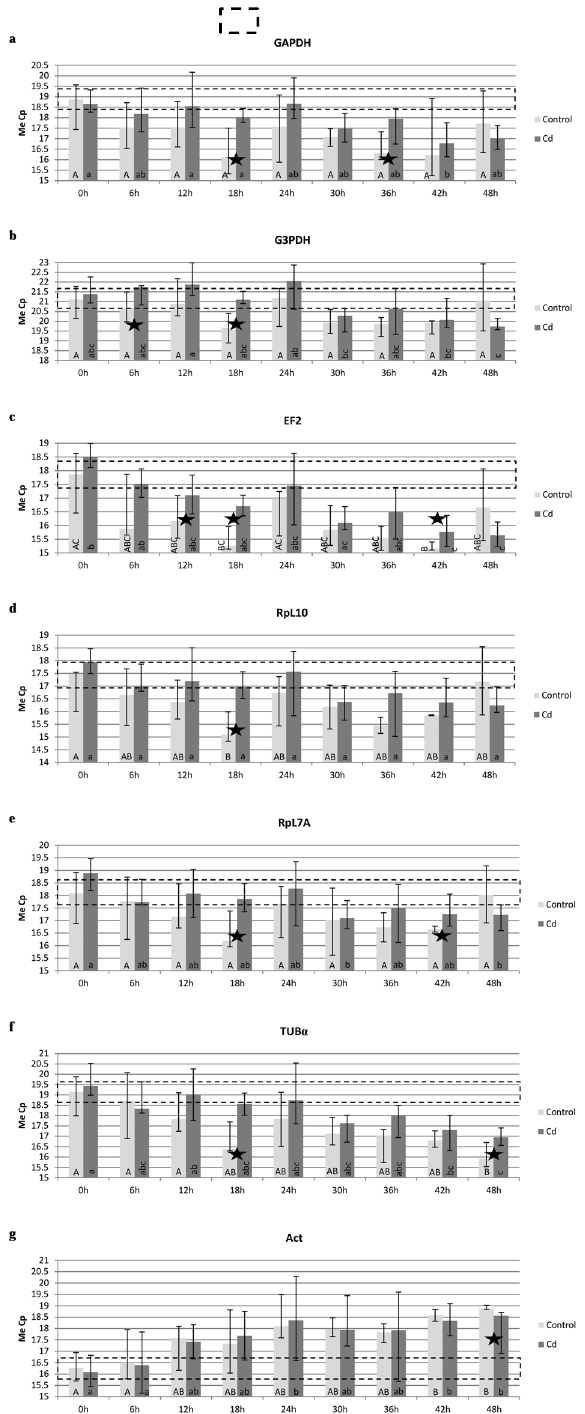
Figure 2. Comparison of the housekeeping genes expression in the control and cadmium strain of S podoptera exigua at different time points for: ( a ) GAPDH, ( b ) G3PDH, ( c ) EF2, ( d ) RpL7A, ( e ) RpL10, ( f ) TUB α and ( g ) ACT. Statistical differences between time-potins within experimental group (control and cadmium) were calculated using the Kruskal-Wallis test (p < 0.05) and between experimental groups (control and cadmium) within one time-point were calculated using U Mann-Whitney test (p < 0.05). ★ Differences between breeding strains: control and cadmium. Acceptable median of Cp value with its min-max value. Abbreviations: glyceraldehyde 3-phosphate dehydrogenase (GAPDH), glycerol-3-phosphate dehydrogenase (G3PDH), time groups within control strain. The same small letters means: no significant differences among time groups within cadmium